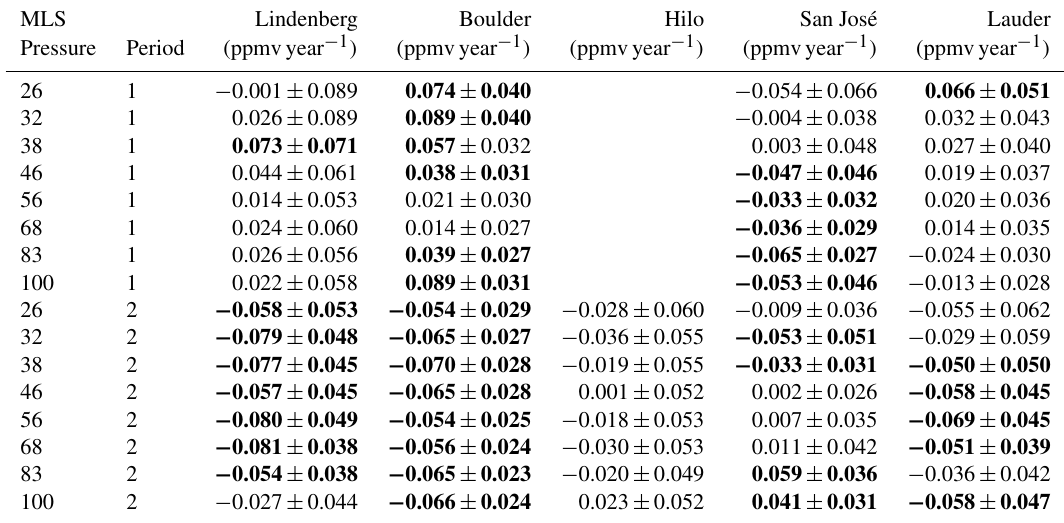
Table 3. Linear regression slopes of FP–MLS v3.3 differences. Slopes are presented with their 95% confidence intervals. Periods 1 and 2 refer to the intervals before and including the changepoint (Table 2) and immediately after the changepoint to 30 June 2015, respectively. Values in boldface type are statistically different from zero with 95% confidence.